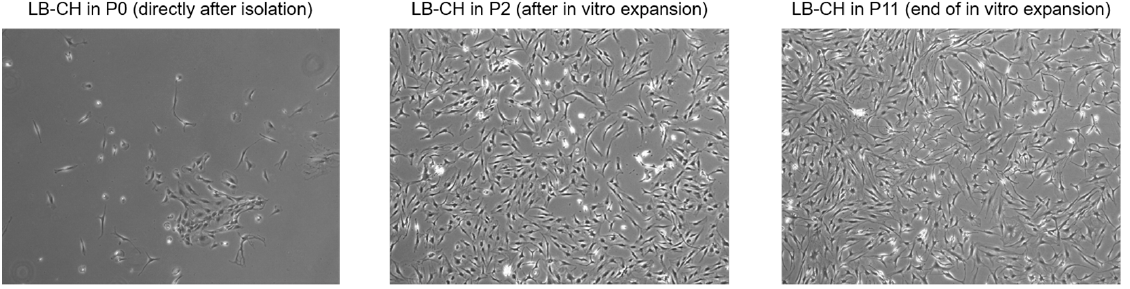
Figure A2. Representative light microscopy images of LB-derived cells ( left ) directly after isolation in passage (P) 0, ( middle ) after in vitro expansion in P2, and ( right ) at the end of expansion.